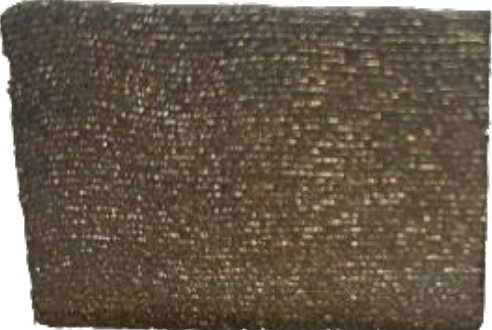
Figure 4: Selected wall (f) from Table 3